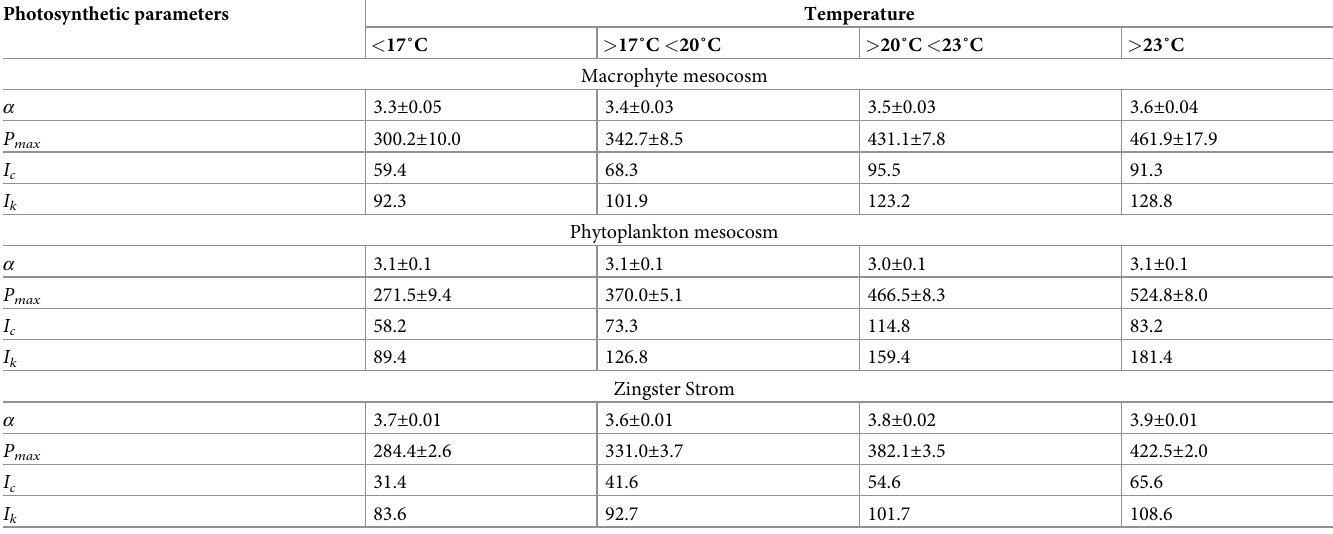
α : initial slope of the light saturation curve μ mol O 2 mg Chl a -1 h -1 ( μ mol photons m- 2 s -1 ) -1 ; P max : the maximum production rate μ mol O 2 mg Chl a -1 h -1 ; I c : light compensation point ( μ mol photons m- 2 s -1 ); I : point where the linear initial slope intersects with the light intensity of P k onset of light